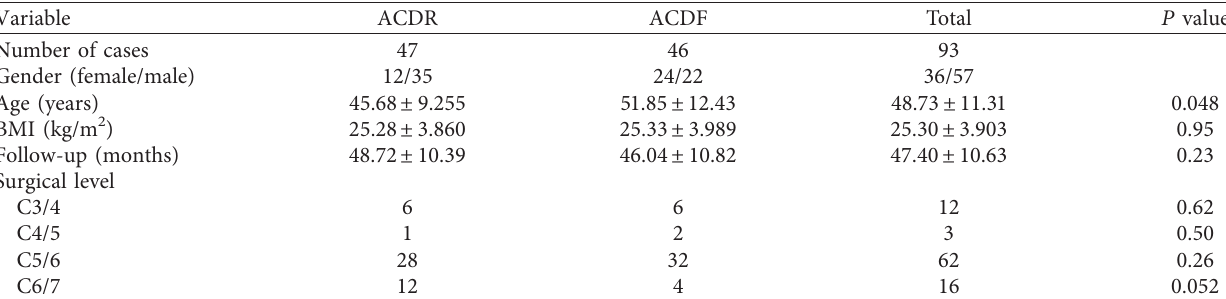
Figure 1: Radiographic measurement of the cervical sagittal alignment parameters. (a) cSVA: the distance between the plumb line from the center of C2 and the superior posterior corner of C7; CL: the angle between C2 (the inferior endplate) and C7 (the inferior endplate); (b) T1s: the angle between T1 (the superior endplate) and a horizontal line; ISH: average of anterior disc height (ADH) and posterior disc height (PDH). Abbreviations: cSVA, cervical sagittal vertical axis; CL, cervical lordosis; T1s, T1 slope; ISH, intervertebral space height; ADH, anterior disc height; and PDH, posterior disc height. Table 1: General information of the patients a .